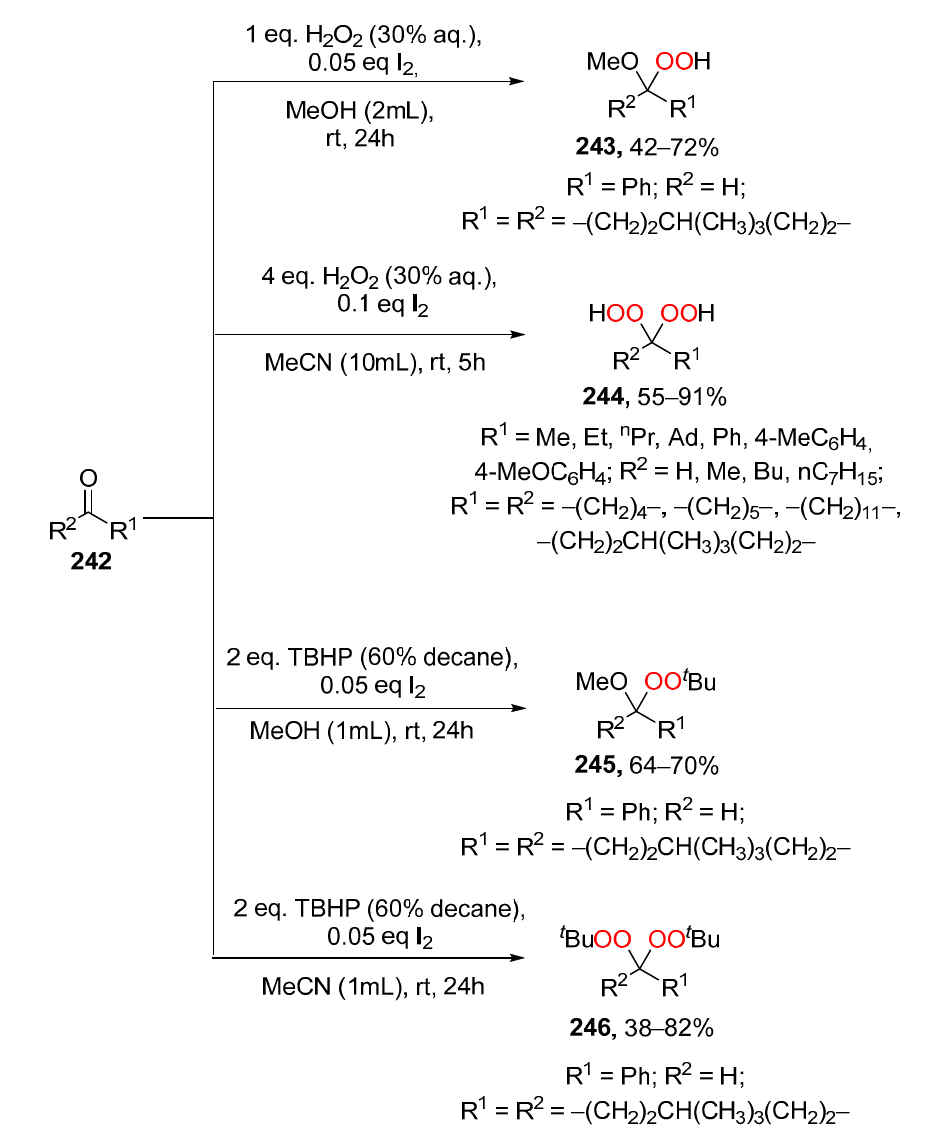
Scheme 91. Iodine-catalyzed peroxidation of carbonyl compounds 242 . The application of I 2 /H 2 O 2 and I 2 /TBHP systems to non-aromatic aldehydes allows one to obtain hydroxy-hydroperoxides 248 and tert -butylhydroxyperoxides 249 (Scheme 92) [190].